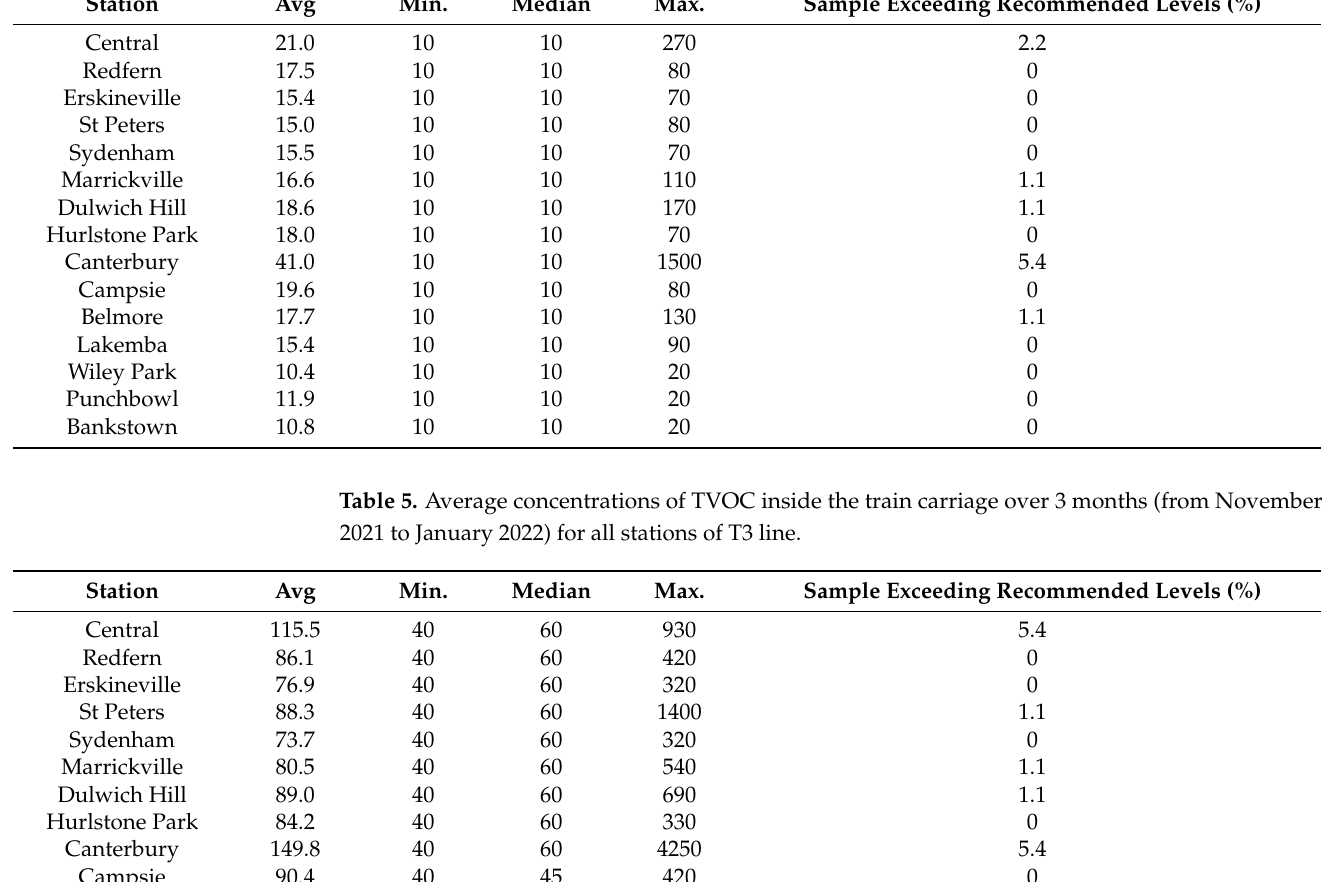
Table 4. Average concentrations of HCHO inside the train carriage over 3 months (from November 2021 to January 2022) for all stations of T3 line. Max.